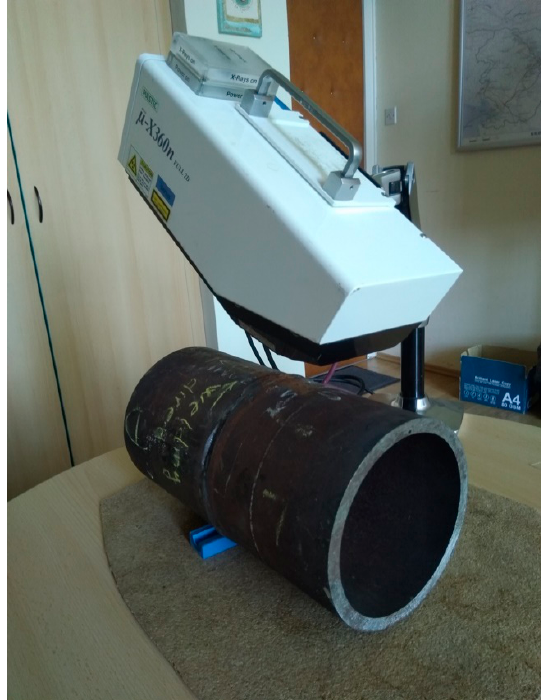
Figure 3. X-ray residual stress measurement.